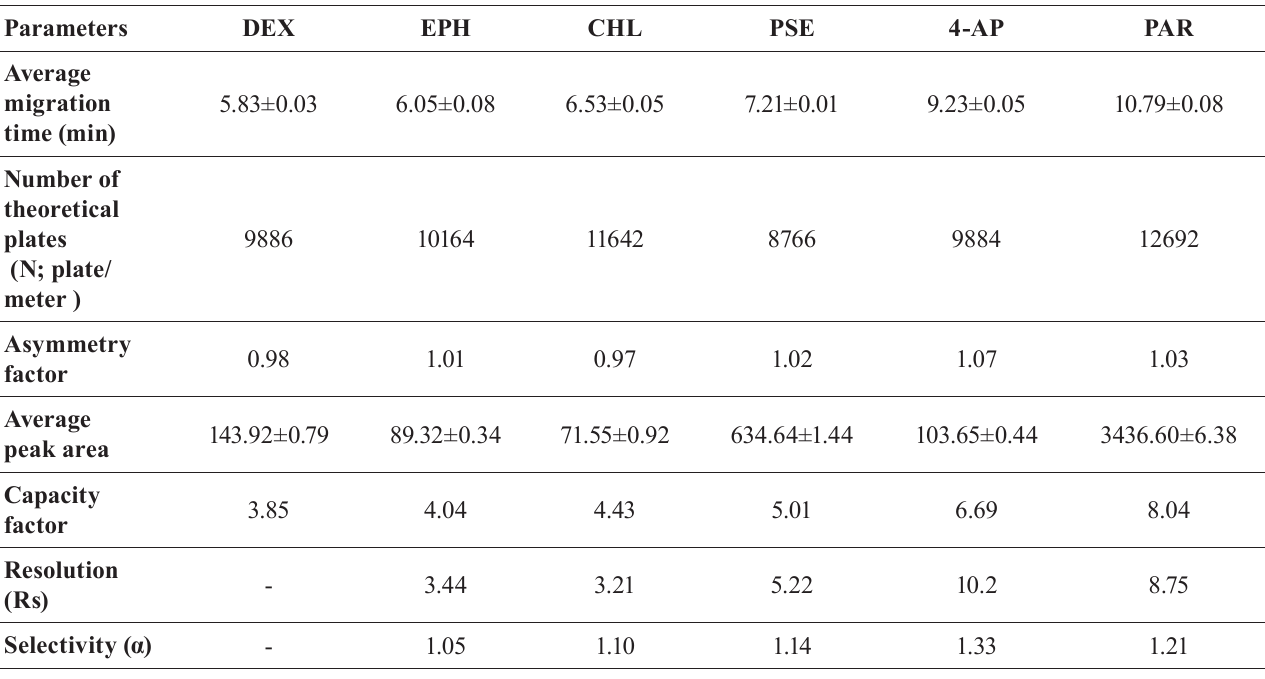
Table SI - Parameters of system suitability tests